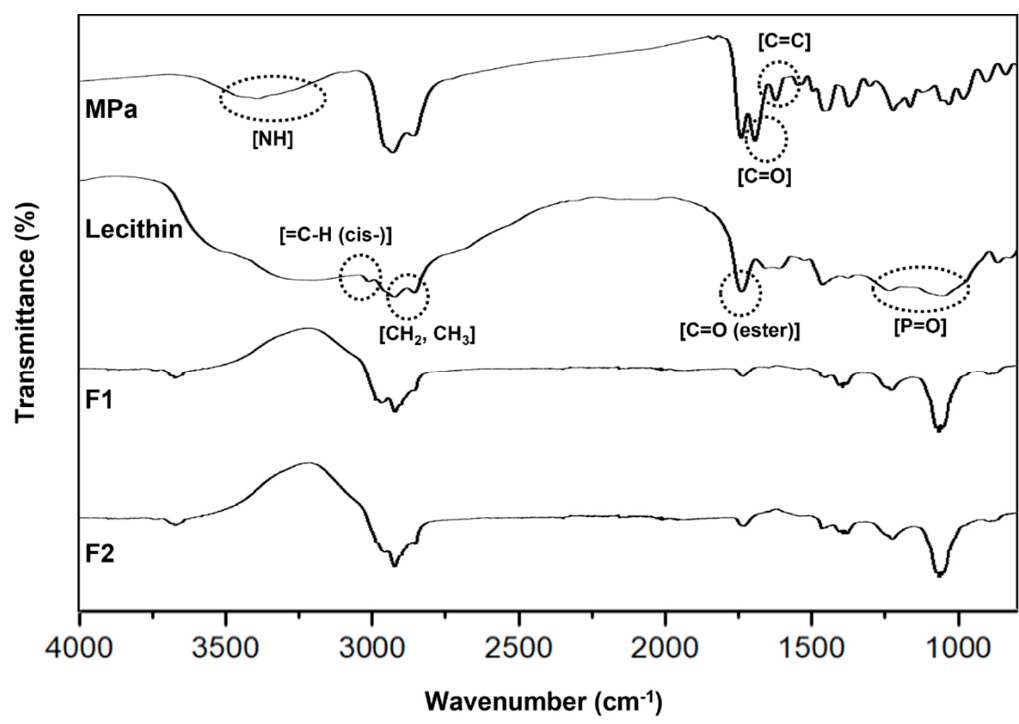
Figure 5. Fourier transform infrared spectroscopy (FTIR) overlay spectra of transfersomes. Pure MPa; lecithin; F1: transfersome consisting of MPa and lecithin; F2: transfersome consisting of MPa, lecithin, and cholesterol. Table 4. Infrared absorption (cm − 1 ) of both C=C; C=O; and NH stretching in MPa, F1, and F2 and CH 2 , CH 3 ; =C-H (cis-); C=O (ester); and P=O stretching in lecithin, F1, and F2.